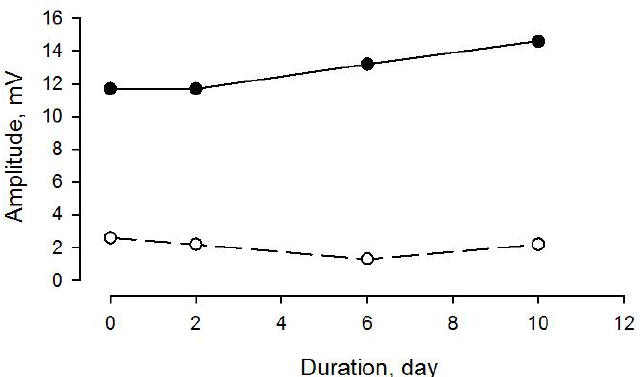
Figure 9. CMAP amplitude upon tibial nerve (filled dots and solid line) and peroneal nerve (open symbol and broken line) supramaximal stimulation and EMG recordings from abductor hallucis (AH) and extensor digitorum brevis (EDB) muscles, respectively, in a neuro-ICU patient exposed to controlled mechanical ventilation for 10 days. After 10 days of ventilation, preferential myosin loss (M:A 1.3) was observed in a distal hind limb muscle (m. tibialis anterior).